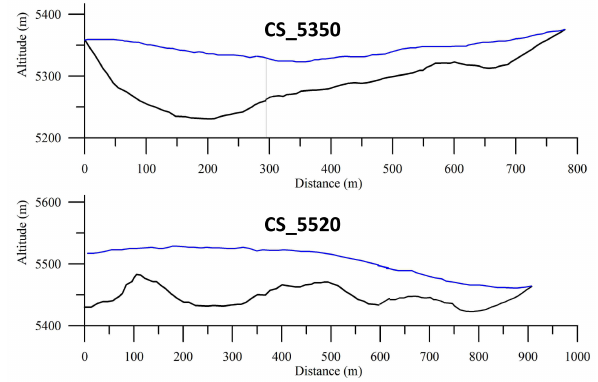
Fig. 10. Ice depths and surface topographies of the two main cross sections CS_5350 and CS_5520 at 5350 and 5520ma.s.l. The ver- tical line at ∼ 300m on CS_5350 represents a discontinuity in the surveyed profile (visible on Fig.